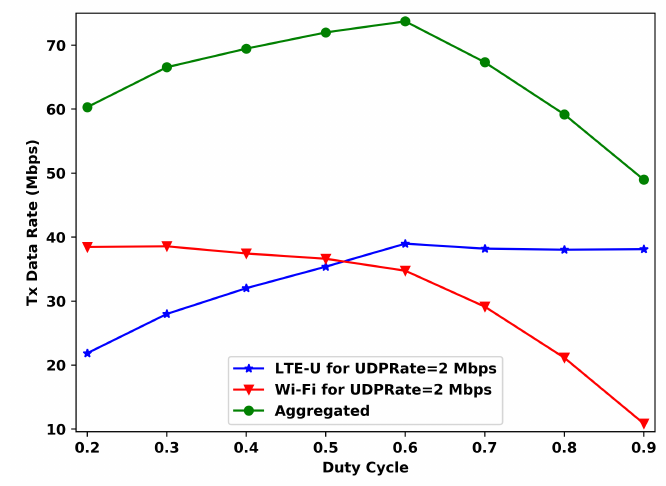
Figure 4. Data rate vs duty cycle (DC) for 2 Mbps of offered data rate per